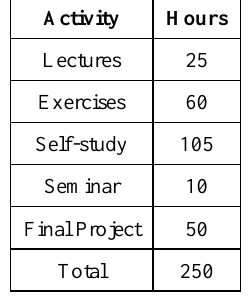
Table 1. Course hour distribution by methods of